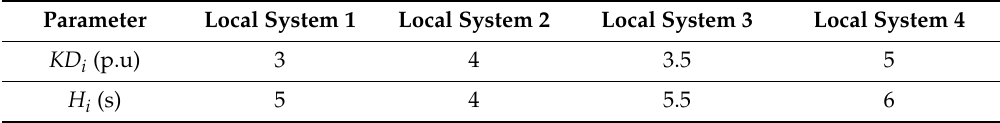
Table 2. Local systems’ parameters.